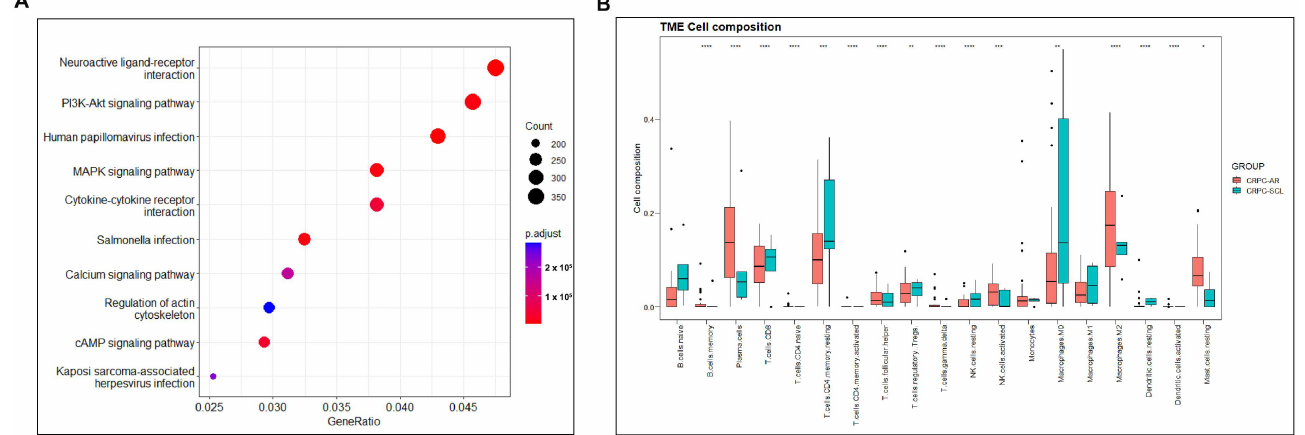
Figure 3. KEGG pathways analysis and immune infiltration analysis of the DEGs between CRPC- AR and CRPC-SCL. ( A ) KEGG pathway analysis of the DEGs between CRPC-AR and CRPC-SCL. ( B ) The differential immune cell infiltration between CRPC-AR and CRPC-SCL. * p < 0.5; ** p < 0.01; *** p < 0.001; **** p <